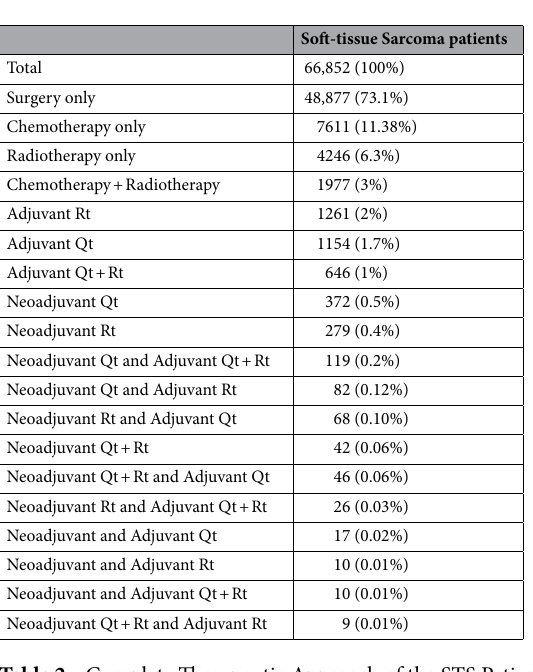
Table 2. Complete Therapeutic Approach of the STS Patient Throughout the Cohort. Qt: chemotherapy; Rt: radiotherapy.